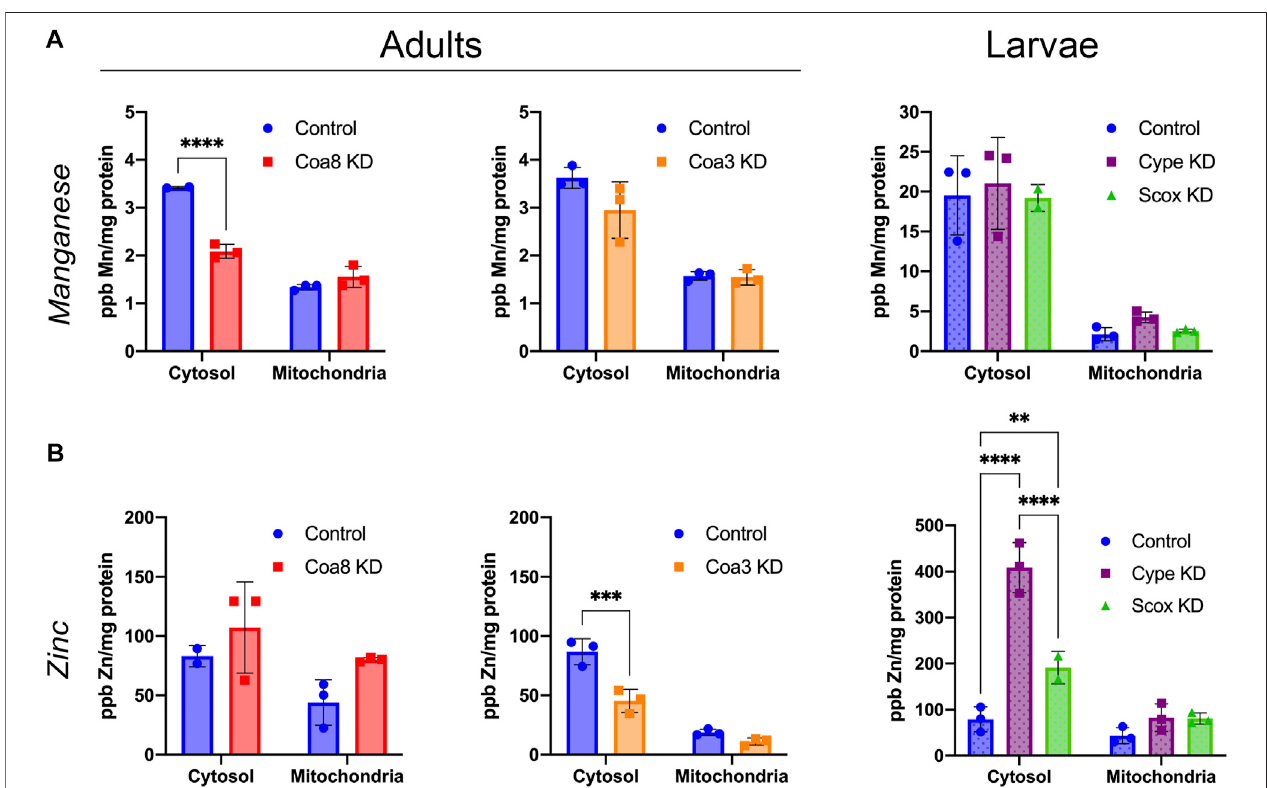
FIGURE 3 | Cellular manganese and zinc compartmentalization in D. melanogaster models of COX de fi ciency. (A) Manganese and (B) zinc content in parts per billion (ppb) and normalized by protein content (mg protein) in cytosolic and mitochondrial fractions from control adults (solid blue bars), Coa8 KD adults (solid red bars), Coa3 KDadults(solidorangebars),controllarvae(dottedbluebars), cype KDlarvae(dottedpurplebars)and Scox KDlarvae(dottedgreenbars).Thesymbolsrepresent the individual values of each replicate measurement and the bars represent the mean ± SD. The statistical signi fi cance was calculated using two-way ANOVA and